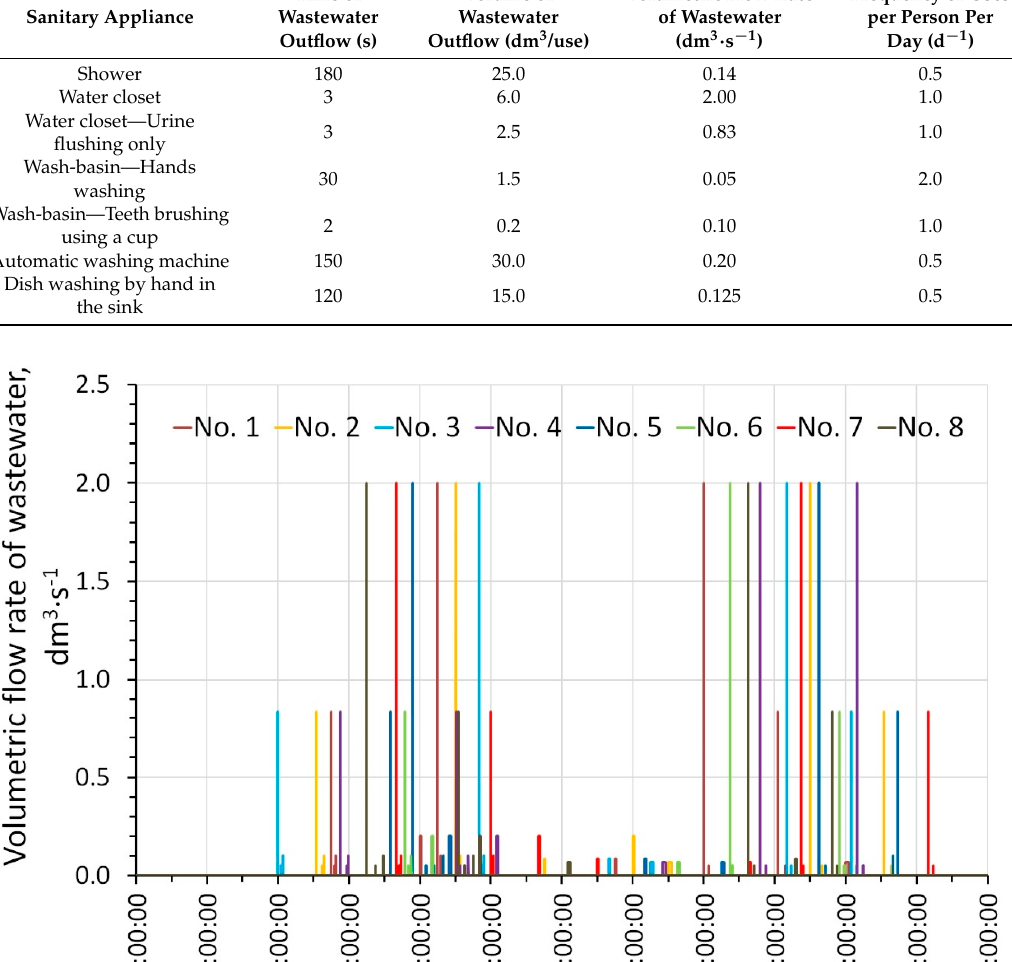
Table 2. Assumed values of parameters describing appliances used in a typical household [47].